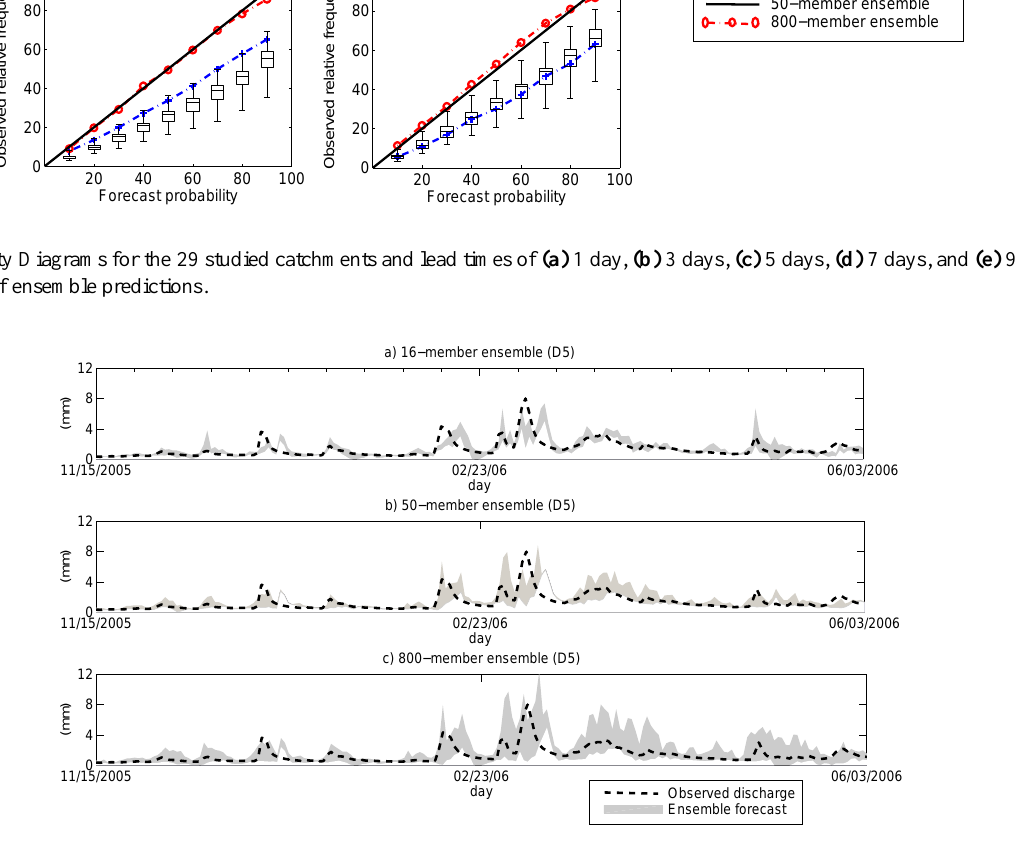
Fig. 6. Example of ensemble hydrographs (lead time 5 days) for a given catchment (A6921010: River Meurthe at Laneuveville-devant- Nancy; area=2780km 2 ) and three types of ensemble predictions (areas in gray). Observed discharges are represented by tick